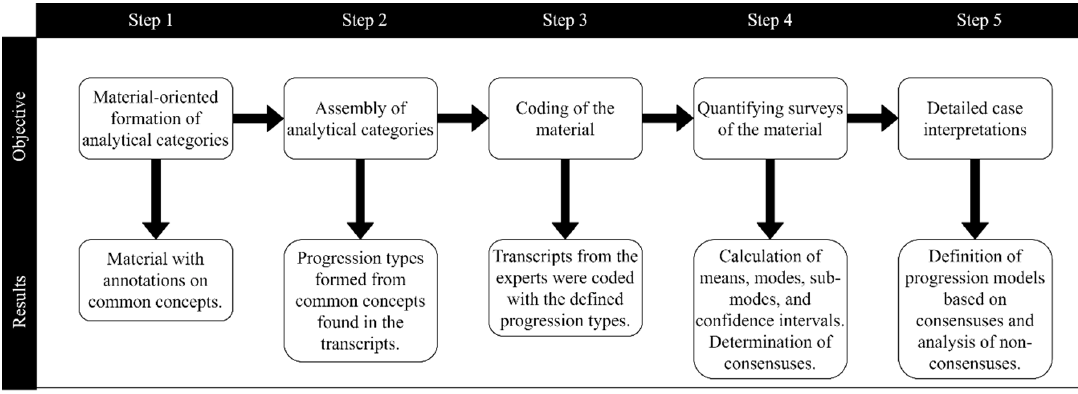
Figure 3. Transcript analysis methodology summary.